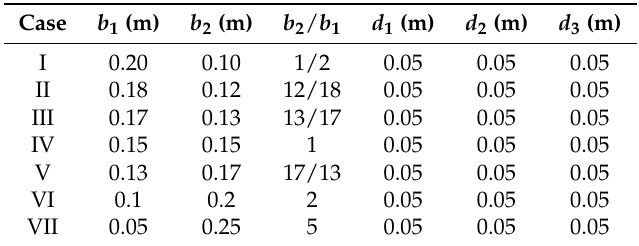
Table 2. Cases for different front ( b 1 ) and rear ( b 2 ) chamber